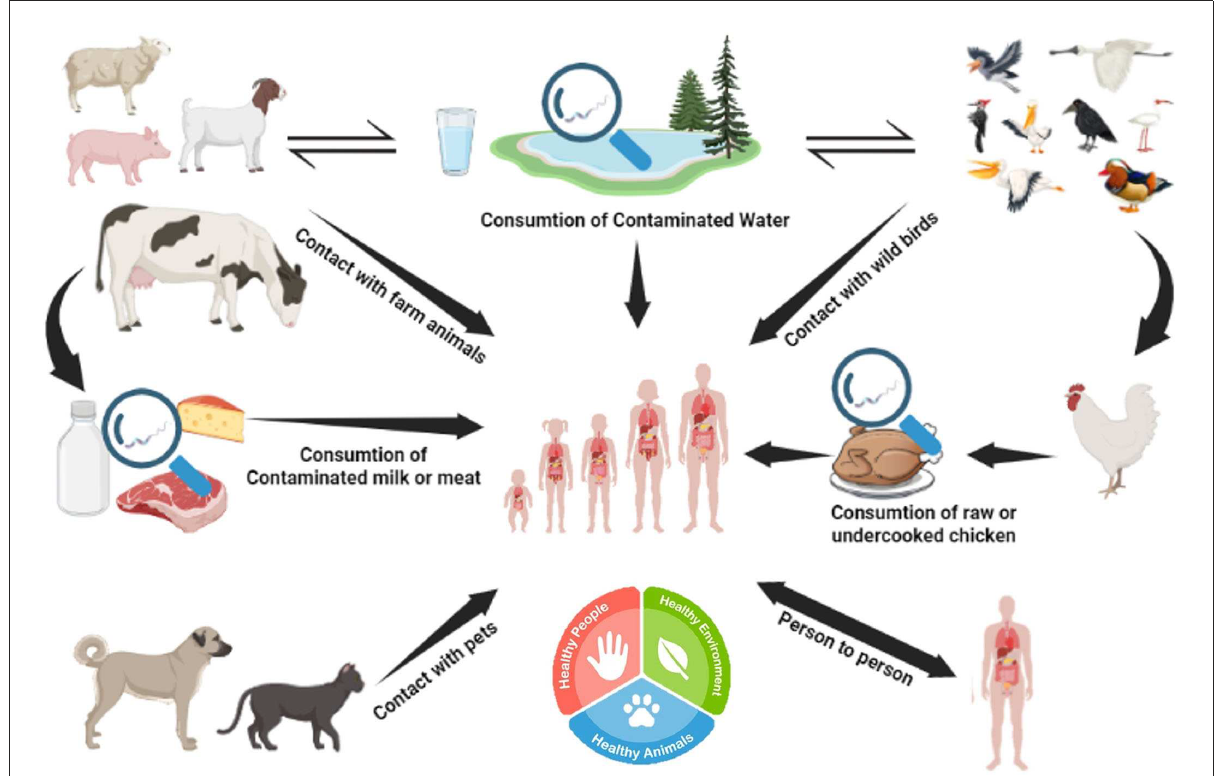
FIGURE7 Reservoir and transmission of Campylobacter . Campylobacter jejuni can survive in various animals (poultry, cattle, and wild birds) and water reservoirs. Humans can acquire C. jejuni from consuming contaminated meat or meat products.